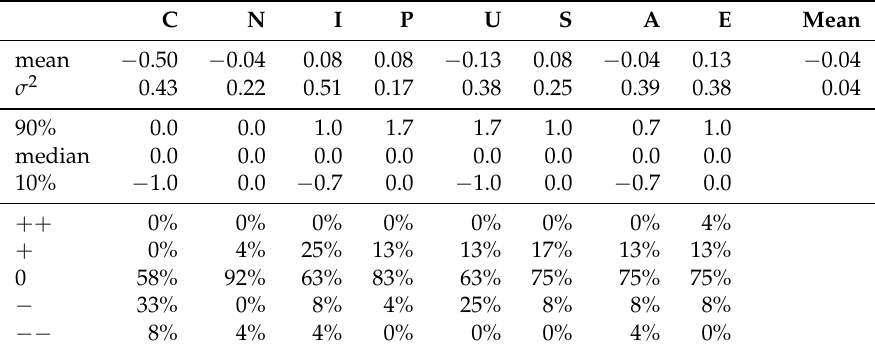
Table 5. Results from the opinions of 24 participants, showing mean, std.dev., 10% percentile, median, 90% percentile and percentages for each of the five alternatives C N I P U